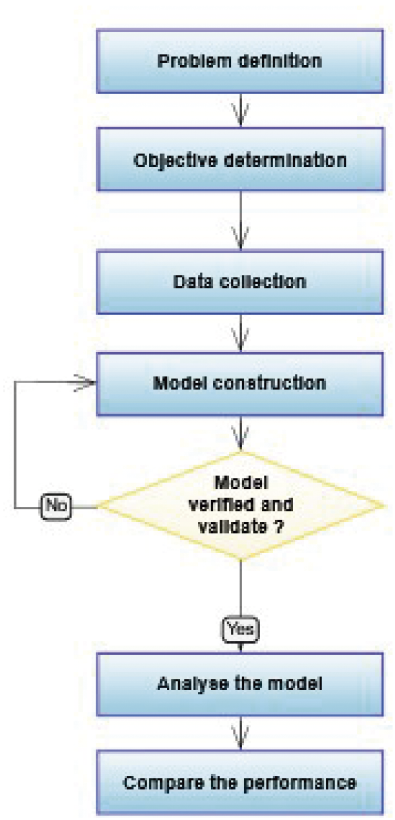
Figure 2. The procedure for building a digital production model (Ruiz-Zúñiga, Urenda-Moris & Syberfeldt, 2016; Ng, Persson & Urenda-Moris,